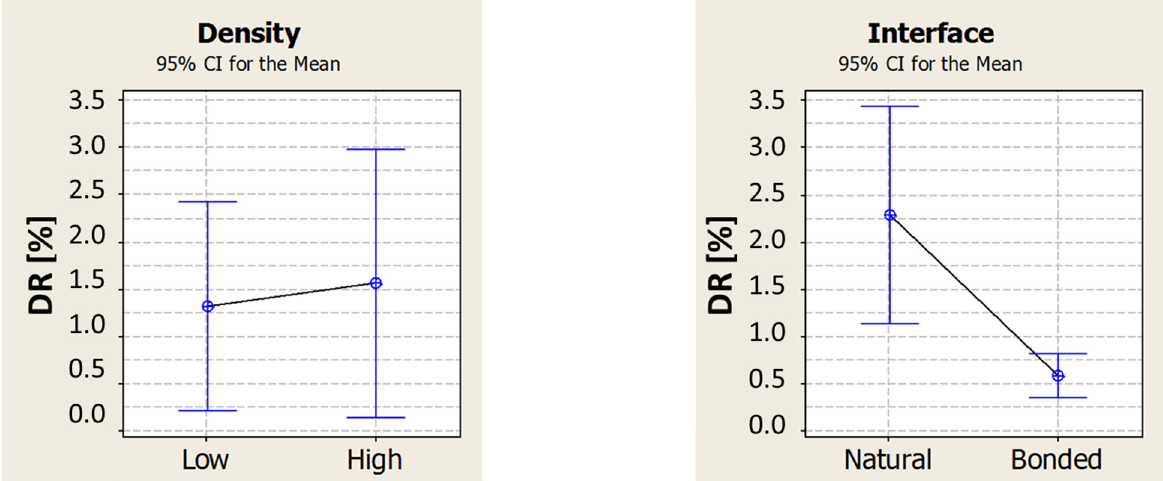
Figure 9. Effect of foam density and interface condition on damping ratio in the low-frequency range (1st mode of vibration).